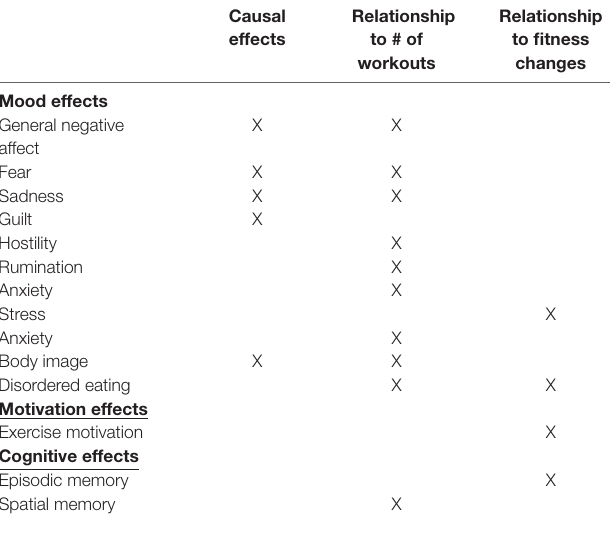
TABLE 7 | Summary of the causal and correlational effects of chronic aerobic exercise in middle-aged adults. Causal effects refer to time ∗ group effects. Causal